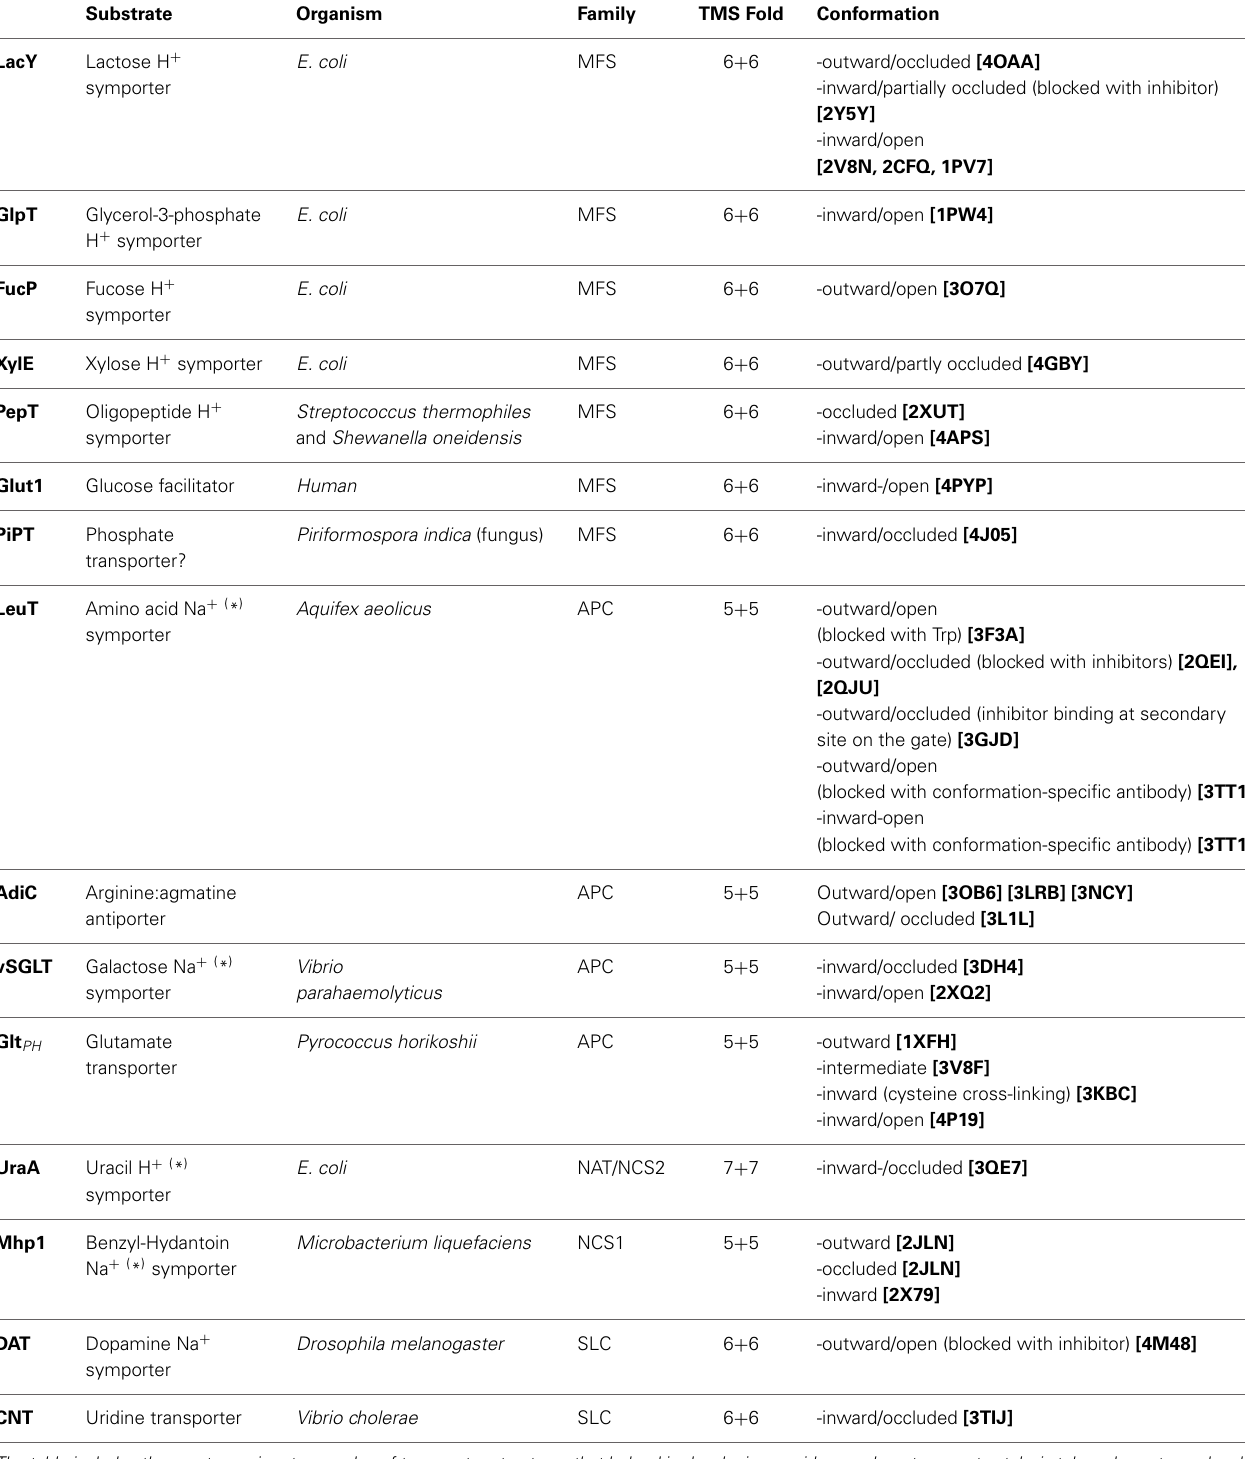
Table 1 | Transporters with known structures caught at various